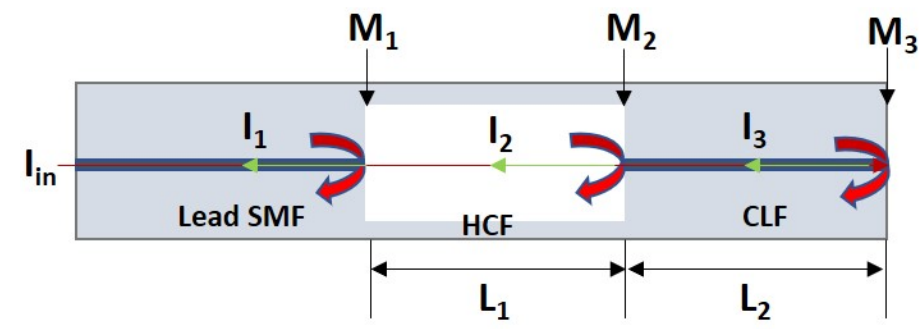
Figure 1. Schematic of the designed cascaded Fabry–Perot interferometer.